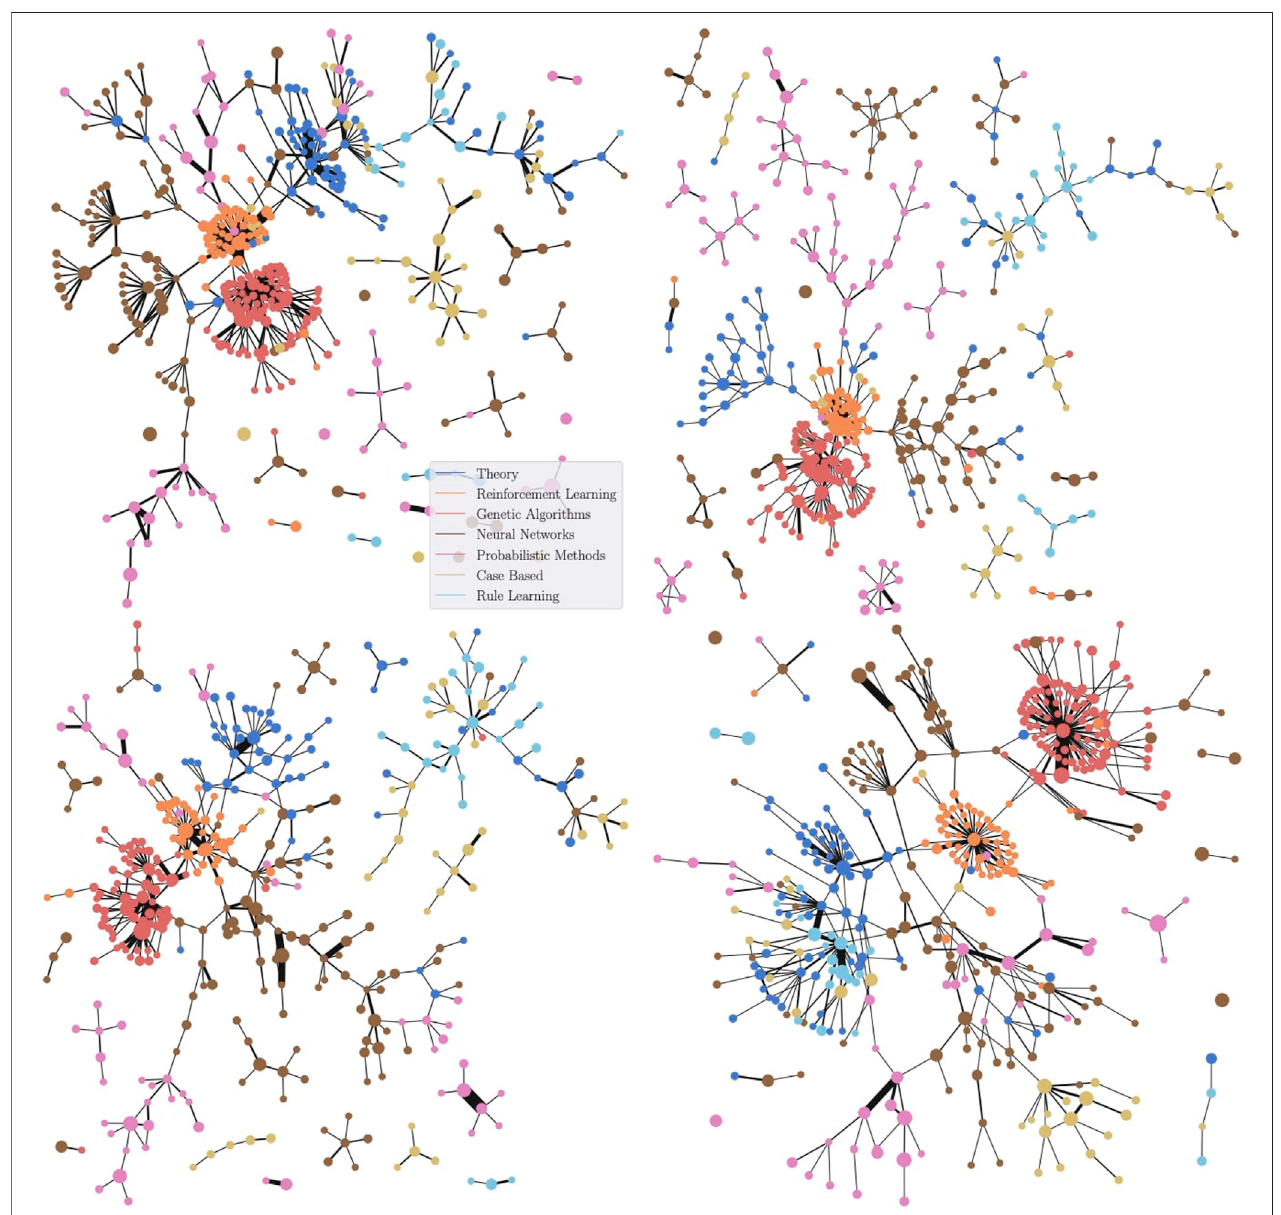
FIGURE 5 | Ablation for dimensionality reduction methods; left – right, top – bottom: t -SNE, PCA, Isomap, UMAP. While t -SNE and UMAP produce slightly better visualisations, the graph features displayed by the visualisations are roughly consistent across all of the four dimensionality reduction techniques.